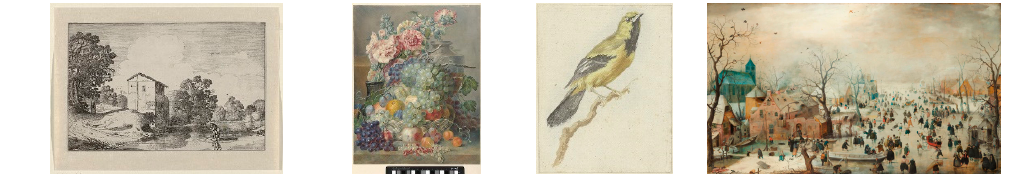
Figure 3. Some artworks from the Rijksmuseum dataset.